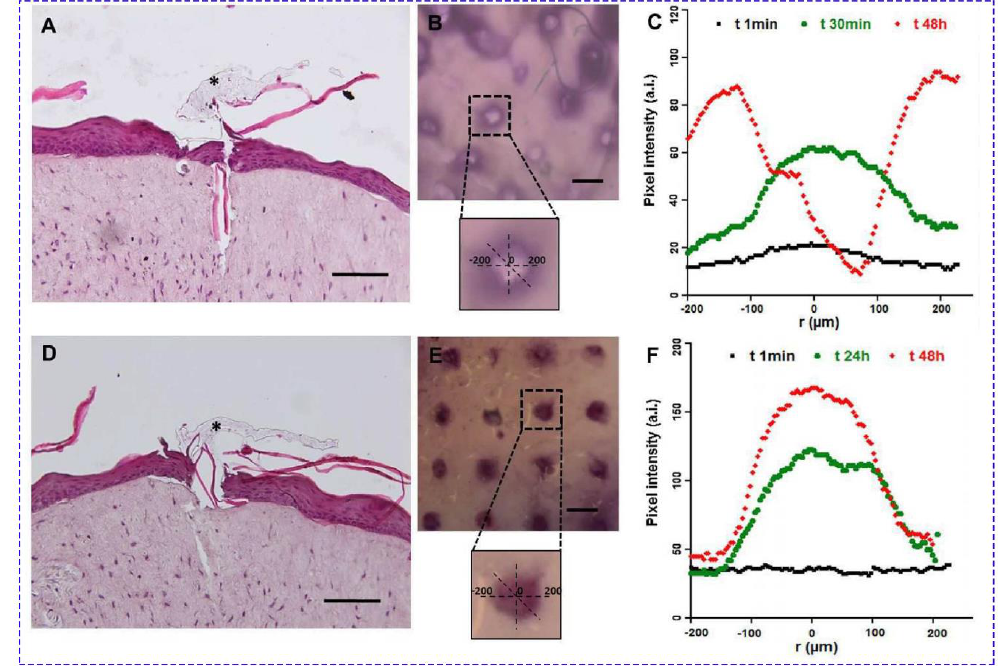
Figure 4. Functional test of MNs in a full-thickness human skin model. The pictures in ( A , B , C ) refer to the encapsulating enzyme in the tip; ( D , E , F ) refer to enzyme-encapsulated microparticles. A D Histological images after 48 h; black asterisks indicate the polyvinyl pyrrolidone (PVP) polymer remained after removing the patch (scale bar = 100 µm). B E Stereomicroscopic images of Endo-Human Skin Equivalent (Endo -HSE) (histological ) 48 h after indentation (scale bar = 500 µm). The inserts of the stereomicroscopic images are the schematic representation of the methods used to calculate the diffusive radius reported in the x -axis of the successive graphs. ( C , F ): The graphs plot, at three time points, the pixel intensity as it corresponds to the concentration of the substrate oxidation product diffusing into the extracellular matrix vs. the radius of the diffusion pattern. Reprinted with permission from